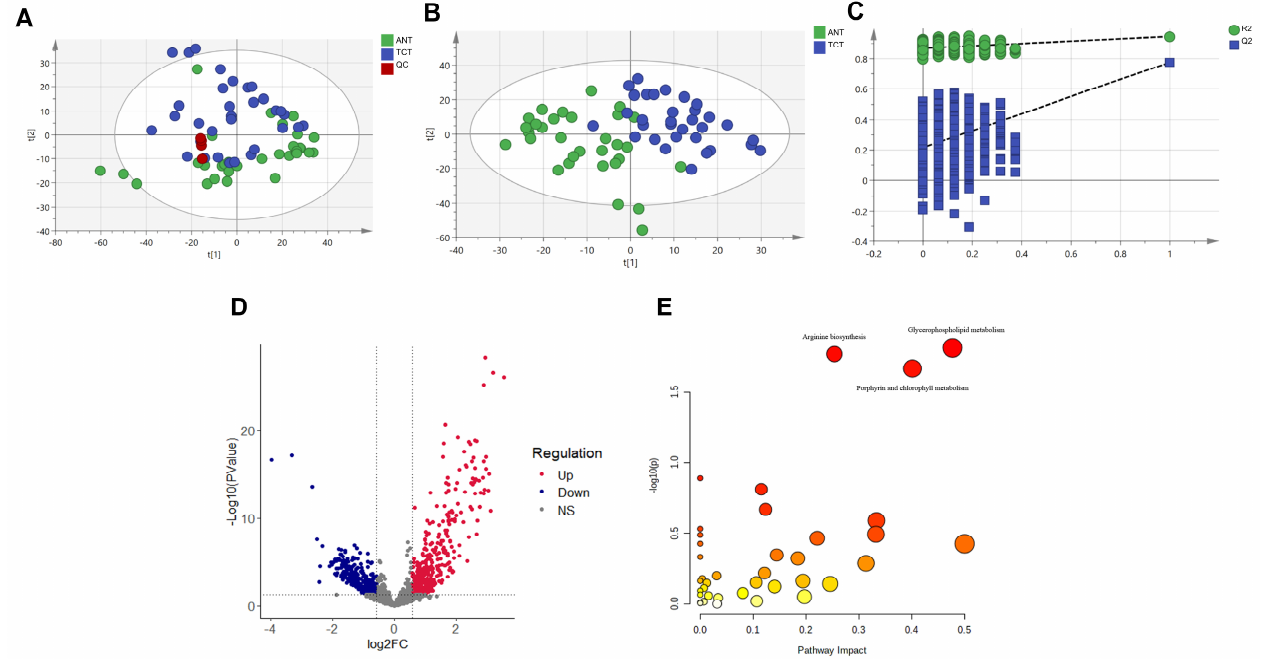
Figure 1. Differential metabolic features and pathways between TCTs and ANTs. ( A , B ) Score plots of PCA and PLS–DA for TNTs and ANTs. ( C ) Results of 1000–times permutation tests of PLS–DA model by cross–validation for TCTs vs. ANTs. ( D ) Volcano diagram revealing changes between TCTs and ANTs. The red dots on the right side of the figure represent upregulated metabolites, the blue dots on the left side mean downregulated metabolites, and the black dots refer to non-significant differences. The x -axis corresponds to the log2-fold change, and the y -axis corresponds to the –log10 p -value. ( E ) Enrichment pathways of differential metabolic features between TCTs and ANTs. The color of the circle indicates the significance level in the enrichment analysis, where a darker color indicates greater significance (pathways with p < 0.05 were annotated); the size of the circle reflects the pathway impact value in the topology analysis, where the larger the circle, the larger the impact value. The x -axis is the pathway impact value calculated based on topology analysis. TNT: thymic cancerous tissue; ANT: adjunct noncancerous tissue; QC: quality control; NS: non- significant.